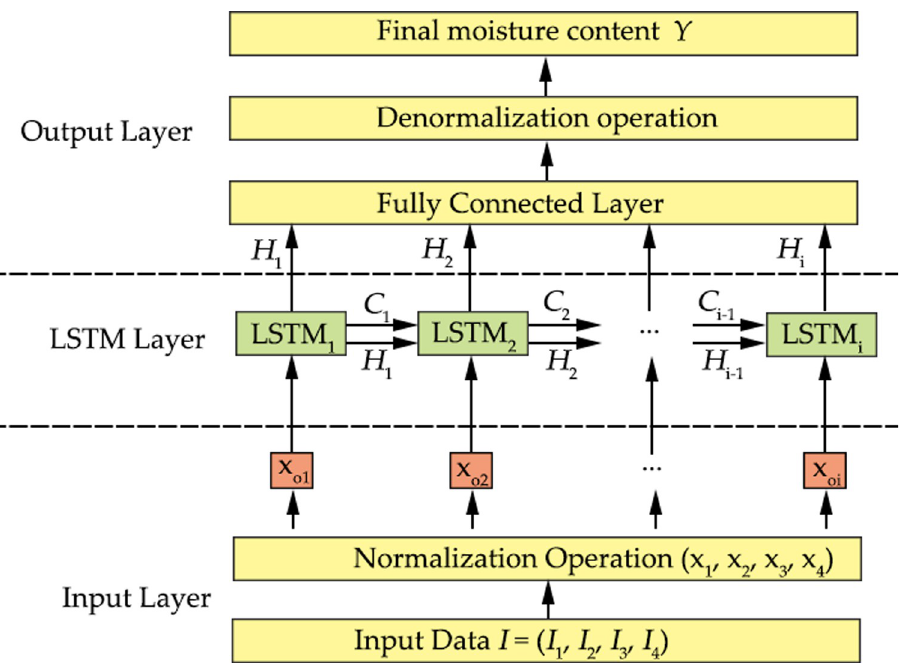
Fig 8. LSTM structure of wood fiber moisture content